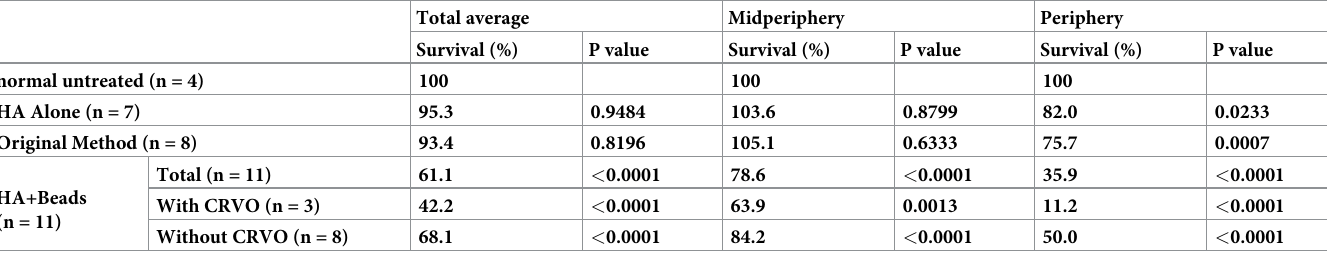
Table 1. Survival ratio of RGCs in each experimental group (% relative to the normal untreated group) at 30 days post-injection. Total average Midperiphery Periphery Survival (%) P value Survival (%) P value Survival (%) P